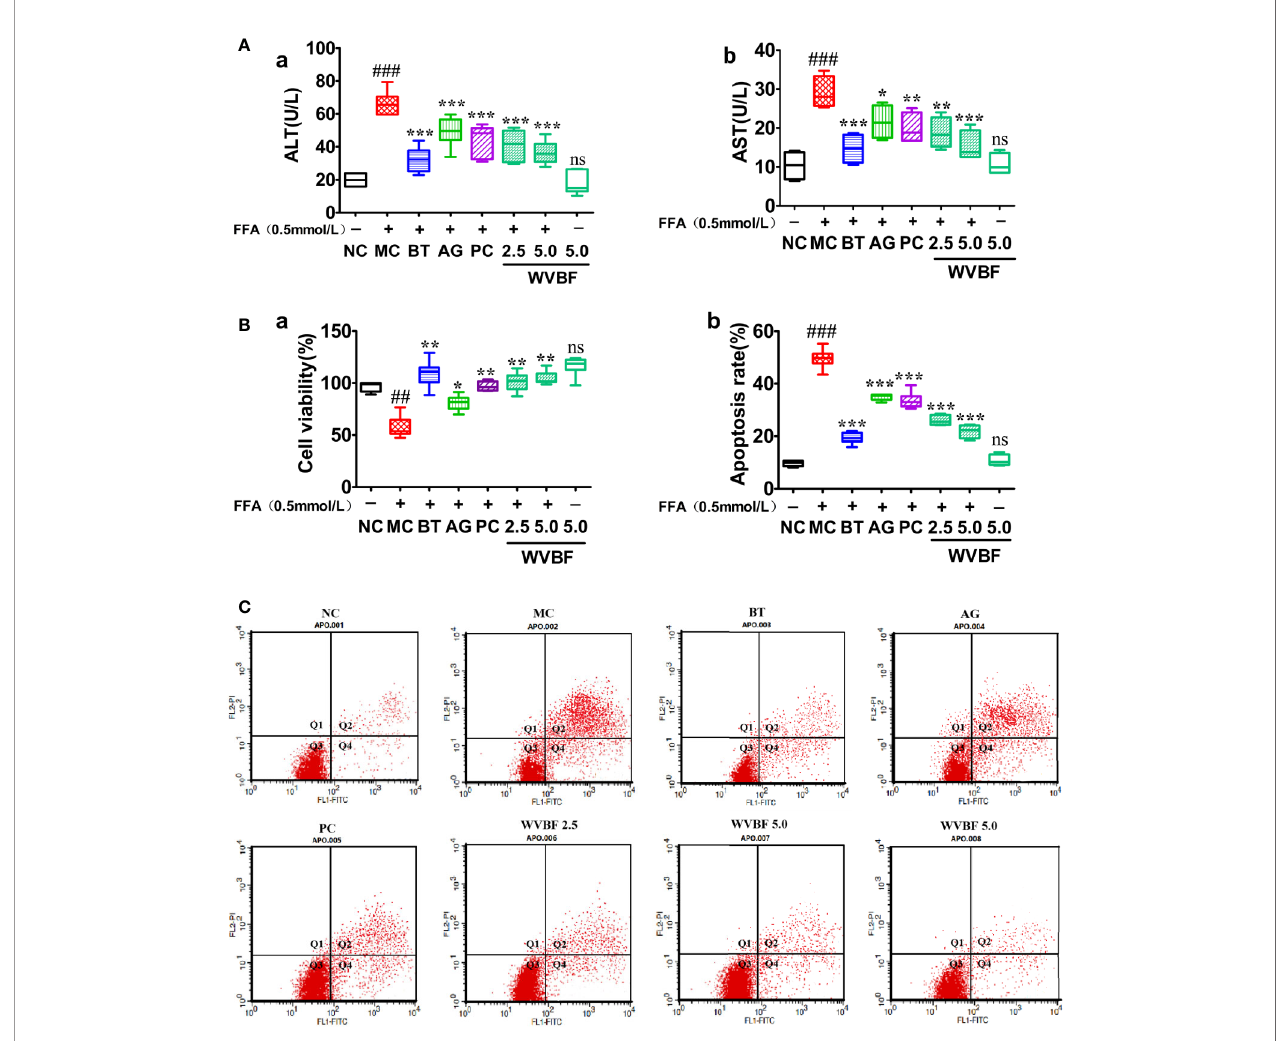
FIGURE 5 | The effect of water extract of Veratrilla baillonii (WVBF) on free fatty acids (FFA)-induced apoptosis and injury. (A) The cell viability was measured by the methylcyclopentadienyl manganese tricarbonyl (MTT) assay, and the levels of alanine aminotransferase (ALT) and aspartate aminotransferase (AST). (B) Annexin V- FITC/PI and analyzed by fl ow cytometry (the upper right quadrant represents late apoptosis. The lower right quadrant represents early apoptosis). (C) Apoptosis rate (a) and necrotic cell rate (b). n =3 ( n , the number of experiment), ( ## P < 0.01, ### P < 0.001 vs . control group; * P < 0.05, ** P < 0.01, and *** P < 0.001 vs . FFA